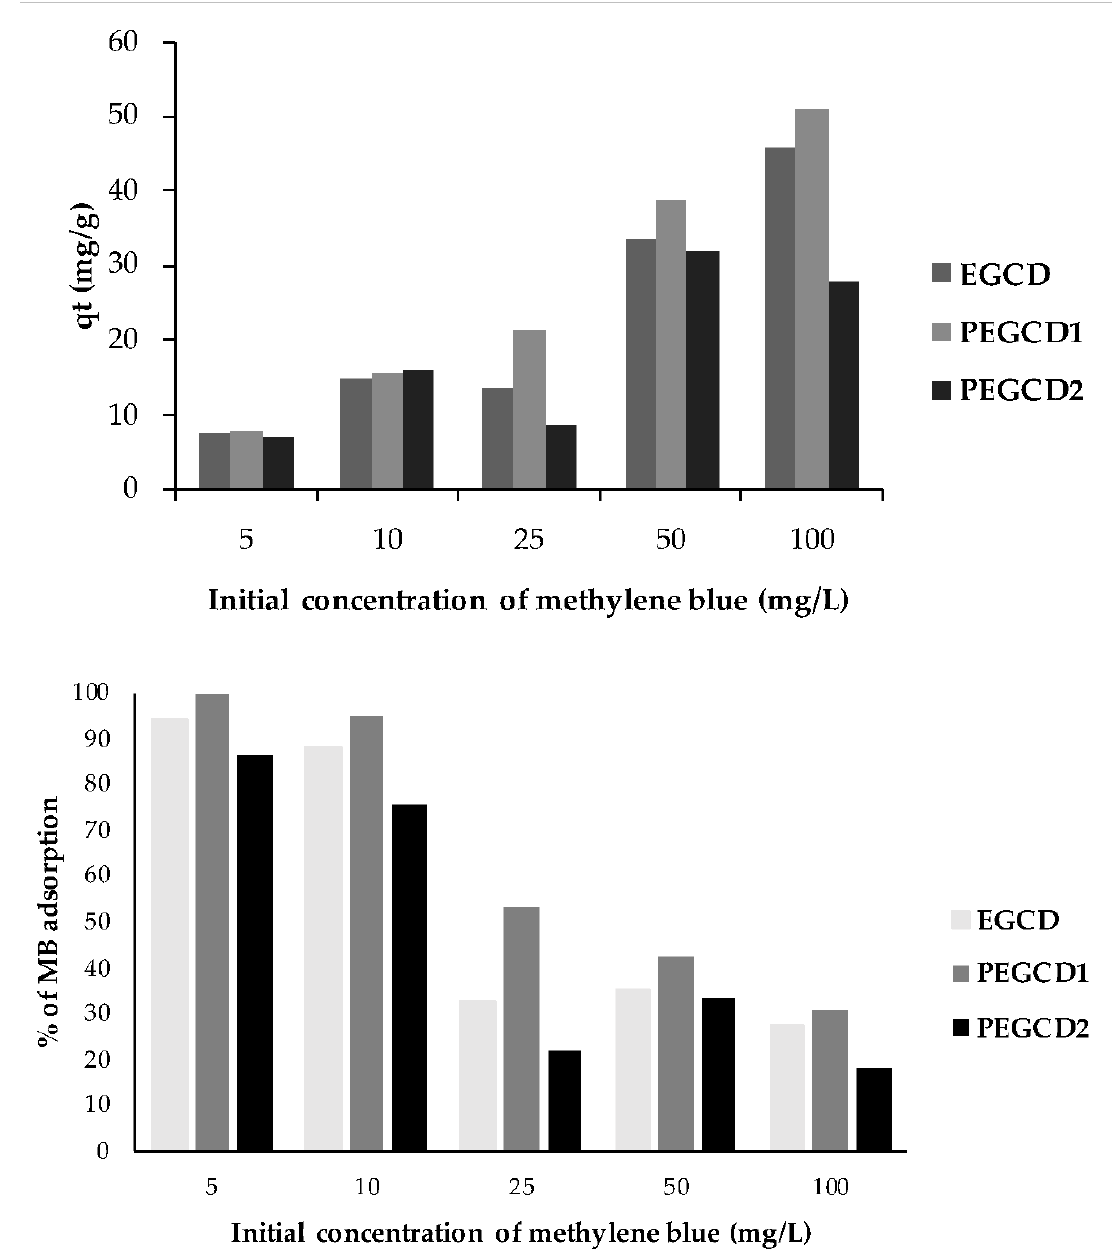
Figure 8. ( Top ) E ff ect of the initial concentration of MB on the adsorption capacity (mg / g) of MB by Figure 8. ( Top ) Effect of the initial concentration of MB on the adsorption capacity (mg/g) of MB by EGCD, PEGCD1 and PEGCD2; and ( Bottom ) e ff ect of the initial concentration of MB on the percentage EGCD, PEGCD1 and PEGCD2; and ( Bottom ) effect of the initial concentration of MB on the of MB percentage of MB adsorption.